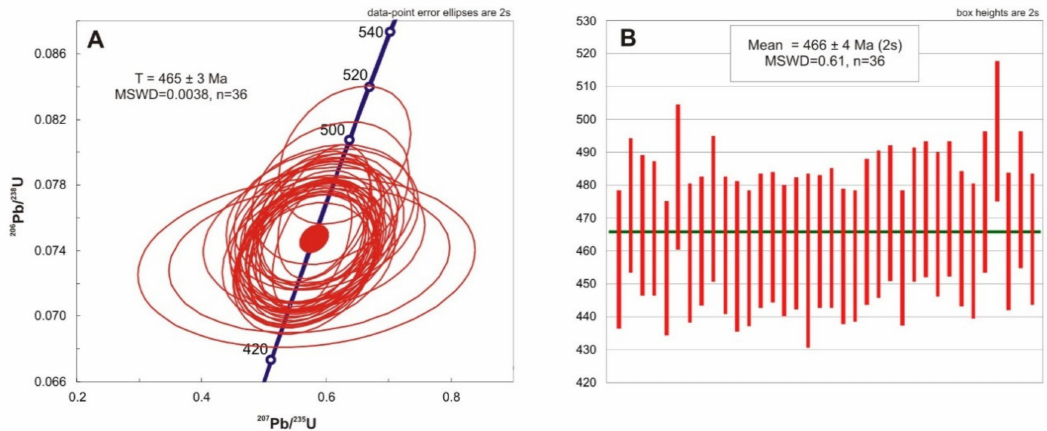
Figure 16. ( A ) Concordia (Wetherill) diagram and ( B ) weighted average LA–SF–ICP–MS 206 Pb / 238 U ages of zircon from the Tog peridotite. Error ellipses / bars are at the 2-sima levels. MSWD = mean square weighted